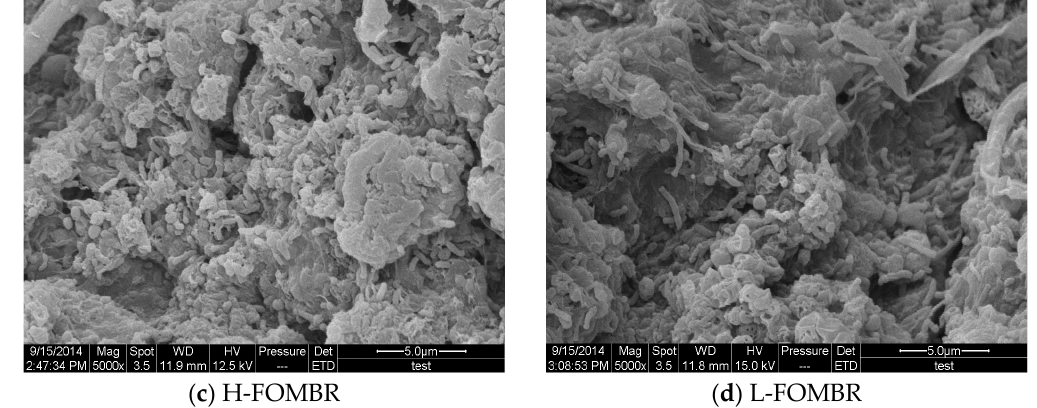
Figure 7. SEM pictures of activated sludge flocs from the ( a ) H-AnMBR and ( b ) L-AnMBR and the ( c ) H-FOMBR and ( d ) L-FOMBR.